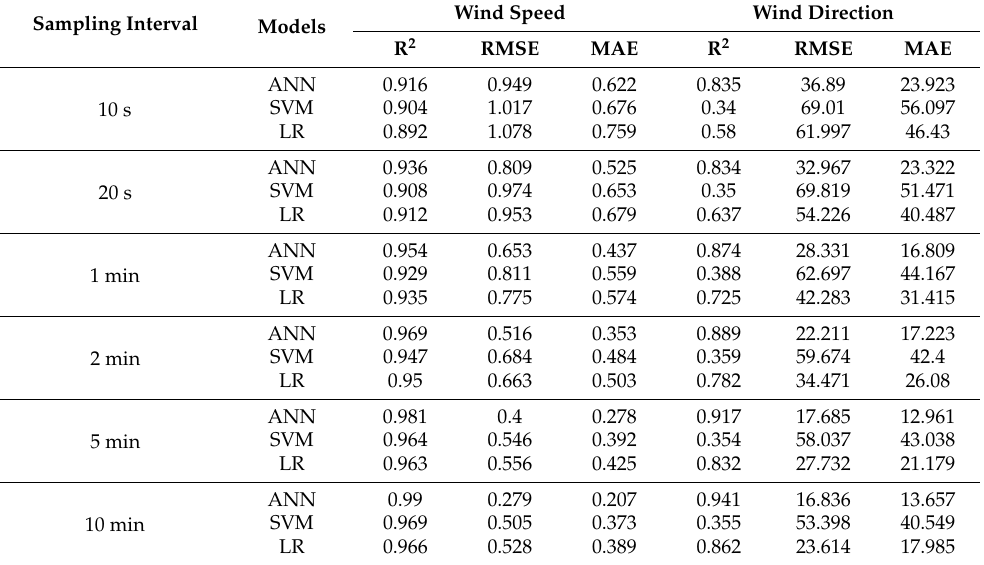
Table 1. Performance evaluation of different regression model for estimating wind speed and direction from the thermopile array and ambient temperature